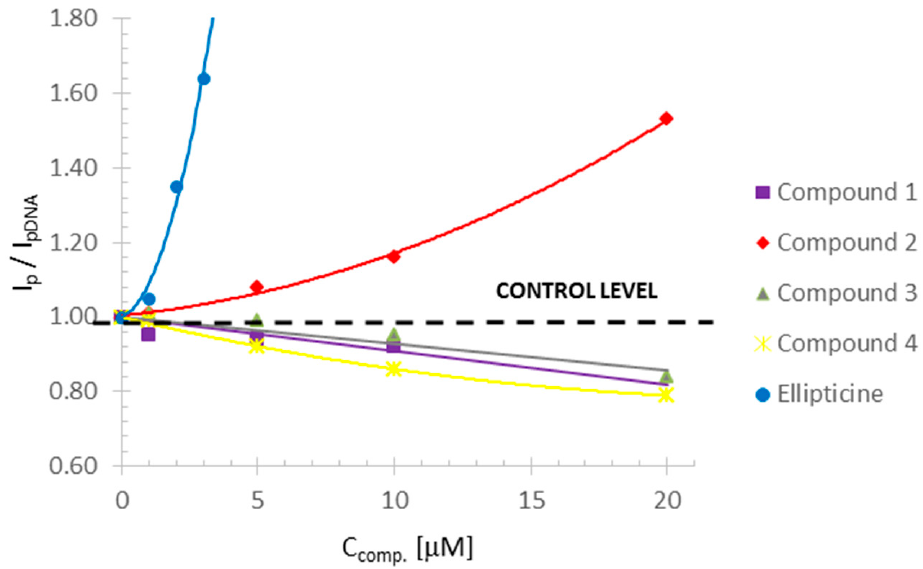
Figure 6. Effect of tested compound concentration on DNA reduction current compared to the control (K = 1). Voltage values of the current according to Table 1.